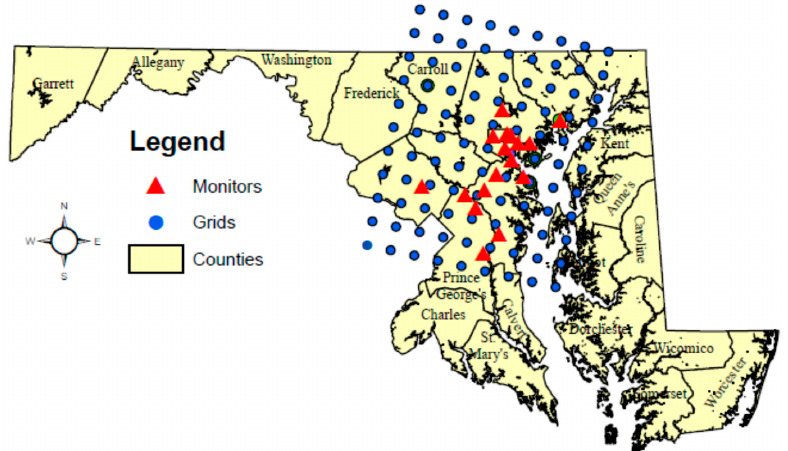
Figure 1. Map shows Maryland’s Counties and Baltimore City in the study area. The extent of the study area is defined by the 1–11 (south–north row) by 1–9 (west–east column) Community Multiscale Air Quality (CMAQ) 12 km 2 grids (blue circles). The 17 Federal Reference Method (FRM) PM 2.5 ambient air monitors are shown as red triangles. Baltimore City and Maryland Counties within the CMAQ grid boundaries provided the 2004–2006 respiratory-cardiovascular chronic disease hospital events included in this data analysis study.